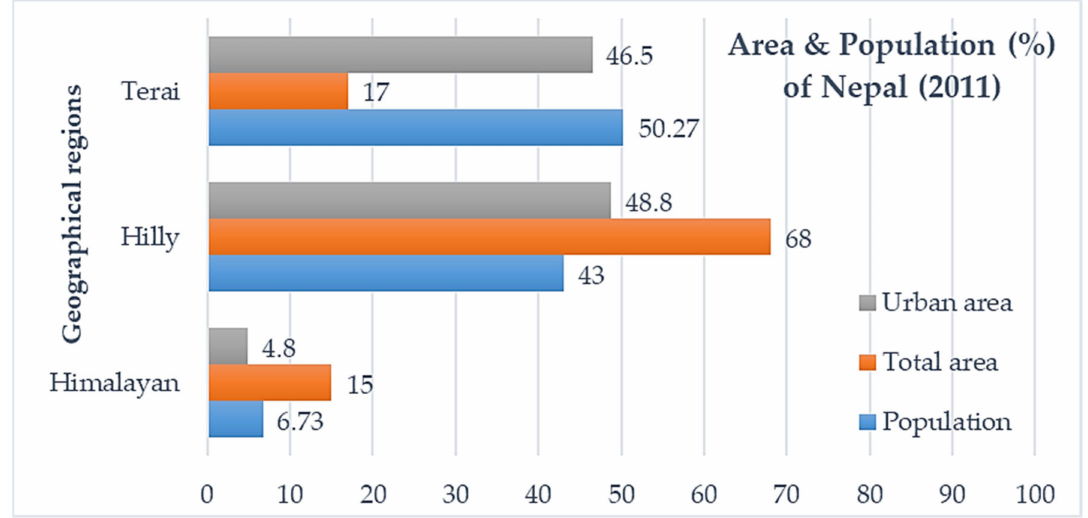
Figure 1. Area of urban center in different geographical regions of Nepal